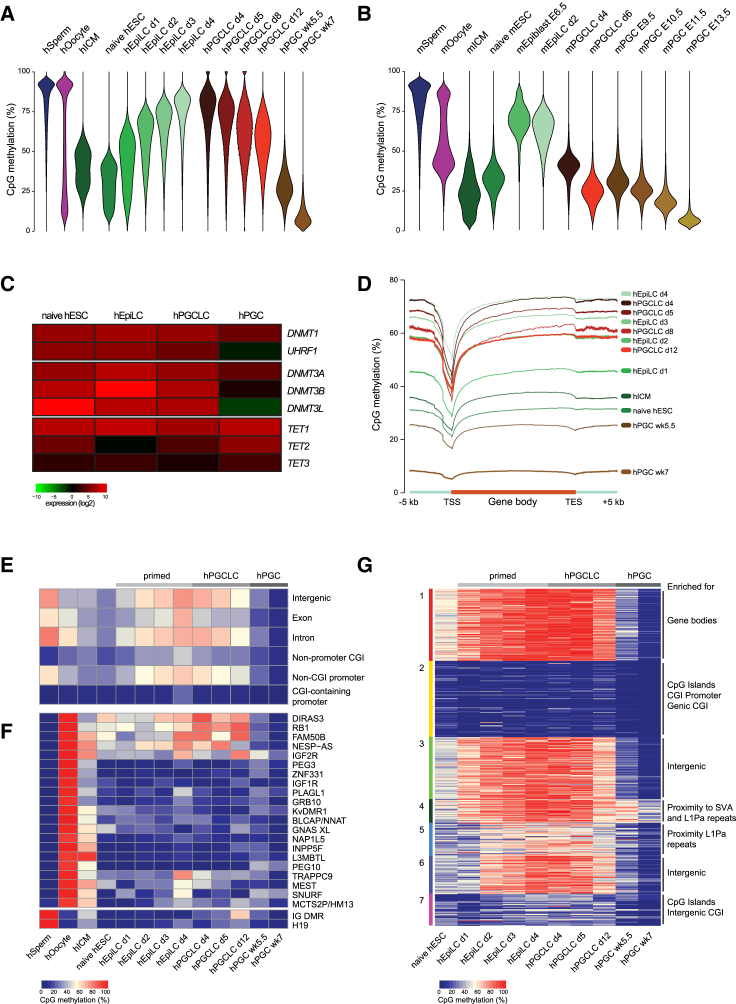
DNA Methylation Dynamics during Human and Mouse PGCLC Specification(A) Bean plots showing the distribution of CpG methylation levels of pooled replicates of human sperm, oocytes, ICM, naive hESCs, primed EpiLCs, PGCLCs, and in vivo PGCs. Methylation was quantitated over 20-kb genomic probes covered by at least ten CpGs.(B) Bean plots showing distribution of CpG methylation levels of pooled replicates of mouse sperm, oocytes, ICM, naive ESCs, epiblast, primed EpiLCs, PGCLCs, and in vivo PGCs. Methylation was quantitated over 20-kb genomic probes covered by at least ten CpGs.(C) mRNA expression levels of key enzymes involved in DNA methylation dynamics in human naive hESCs, primed hEpiLCs, hPGCLCs, and in vivo PGCs. Heatmap shows the average expression (log2) of three biological replicates.(D) Averaged CpG methylation profiles over all human annotated genes starting from 5 kb upstream (−5 kb) of the transcription start site (TSS), through scaled gene bodies to 5 kb downstream (+5 kb) of transcription end site (TES).(E) Averaged CpG methylation of indicated genomic features in the human methylation datasets.(F) Averaged CpG methylation of known DMRs of imprinted maternal and paternal genes in the human methylation datasets.(G) k-Means clustering of 2-kb probes of the human genome, excluding probes overlapping with repetitive elements. Seven clusters were generated and the enrichment of specific genomic features compared with the whole genomes was assessed.Published datasets from human sperm, oocytes (Okae et al., 2014), ICM (Guo et al., 2014), naive ESCs (Takashima et al., 2014), in vivo PGCs (Tang et al., 2015), and mouse sperm, oocytes, ICM (Wang et al., 2014), naive ESCs (Ficz et al., 2013), epiblast, and in vivo PGCs (Seisenberger et al., 2012) were included in the analysis. Biological replicates were pooled and average levels were used for the analysis. See also Figure S2.